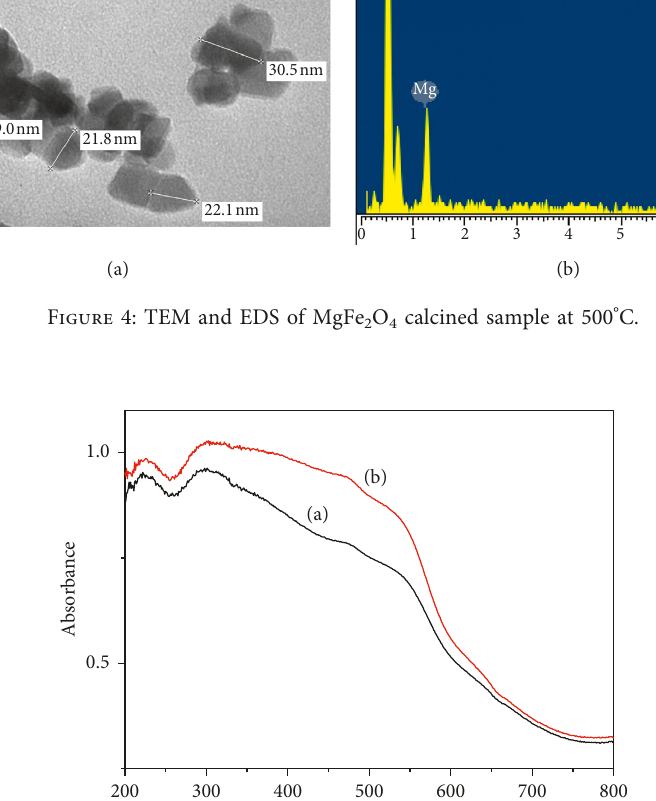
2 O 4 calcined at 500–600 ° C.